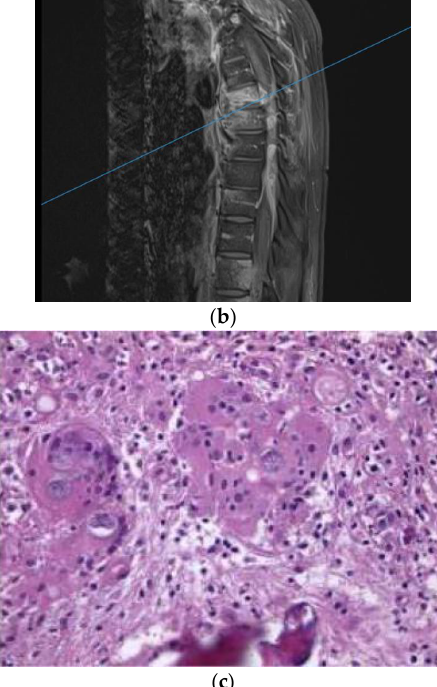
Figure 1. ( a ) Axial T1-weighted magnetic resonance (MR) images with contrast showing extensive vertebral body and soft tissue enhancement with compression of the spinal canal at T6. ( b ) Sagittal T1-weighted MR Images with contrast showing extensive enhancement throughout the vertebral bodies and soft tissue but most significantly at T6–7. (c) Hematoxylin and eosin (H&E) staining of the thoracic bone specimen showing acute osteomyelitis with abundant coccidioides organisms. Multinucleated giant cells with engulfed coccidioides spherules is a characteristic finding. Abundant acute inflammatory changes was noted in the marrow cavity.